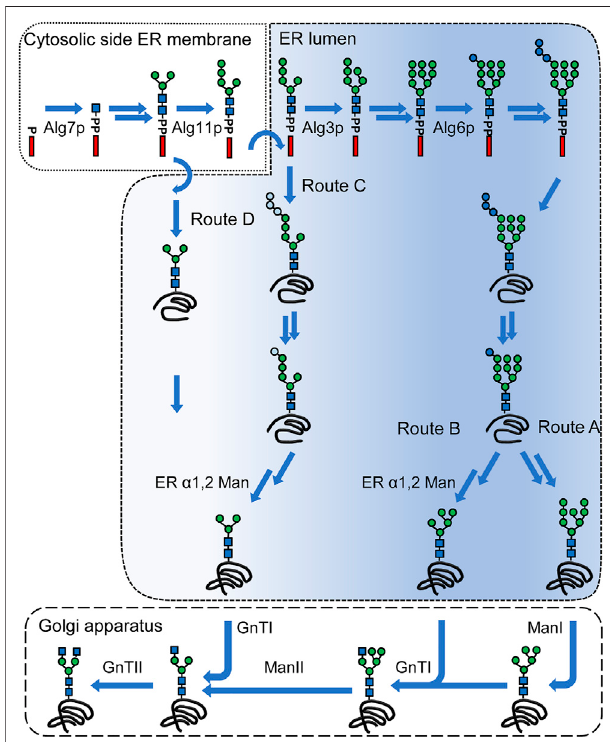
FIGURE 2 | N-linked glycosylation pathways leading to complex-type N-glycans. A simpli fi ed lipid-linked oligosaccharide (LLO) biosynthesis pathway is depicted in the top of the fi gure. LLO synthesis is initiated on the cytoplasmic side of the ER membrane by Alg7p. A Man 5 GlcNAc 2 structure is assembled on the cytoplasmic side by the consecutive action of the mannosyltransferases Alg13/14p, Alg1p, Alg2p and Alg11p. This structure is fl ipped into the ER lumen, where the modi fi cation of the LLO is continued by Alg3p. The B-branch is completed by the action of Alg9p after which the C-branch is started by Alg12p and completed by Alg9p. The triglucosyl cap is added by Alg6p, Alg8p and Alg10p generating a Glc 3 Man 9 GlcNAc 2 . This structure is transferred onto a protein by the oligosaccharyltransferase complex. Two glucose residues are removed and Glc 1 Man 9 GlcNAc 2 mediates binding to calnexin. After release of the protein fromcalnexin andfoldingoftheprotein,theterminalmannoseoftheB-branch is removed (route A). N-glycans of glycoproteins undergo trimming and transfer reactions in the Golgi apparatus. First, α 1,2 mannosidase activities (ManI) are trimming the α 1,2 mannose residues, after which fi rst GlcNAc residueisaddedbyGnTI.Theremainingmannoseresiduesaretrimmedoffby ManII, which create the substrate for GnTII that adds a second GlcNAc residue. Route B) includes an α 1,2 mannosidase activity in the ER that gives rise to the Man 5 GlcNAc 2 glycan structure in the ER. This structure is modi fi ed in the Golgi apparatus by GnTI and route A and B converge. By deletion of ALG3 gene, LLO biosynthesis is abrogated creating a Man 5 GlcNAc 2 that can be glucosylated to varying extent and is transferred onto a protein (route C). After removal of glucose residues and possible interactions with calnexin, an α 1,2 mannosidase activity converts this structure into a Man 3 GlcNAc 2 structure. Alternatively, the Man 3 GlcNAc 2 can be generated biosynthetically by deletion of ALG11 and ALG3 genes and this glycan is transferred onto a protein (route D). The Man 3 GlcNAc 2 glycan structure directly serves as a substrate for GnTI and GnTII. The color gradient indicates the presence or absence of canonical glycan features involved in interaction with calnexin/ calreticulin and Yos9p, respectively. Blue circles: glucose, green circles: mannose, blue squares: N-acetylglucosamine. Light blue circles indicate reducedglucosylationoftheA-branch.Arrowswithoutnames:multiplesteps; arrows with names: speci fi c enzymes are